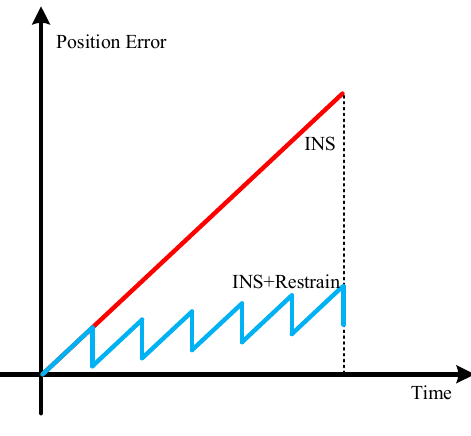
Figure 8. Diagram of the restraining process.